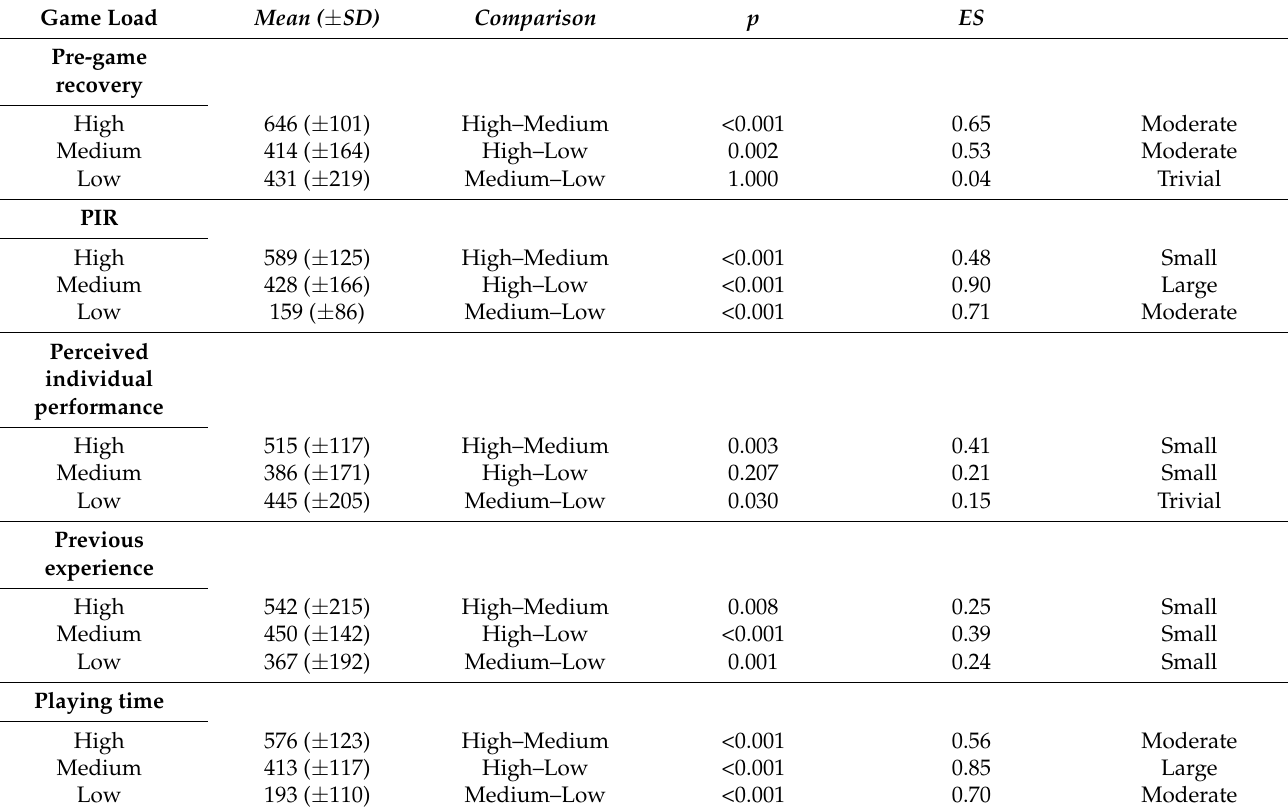
Table 7. Pairwise comparison for game load.